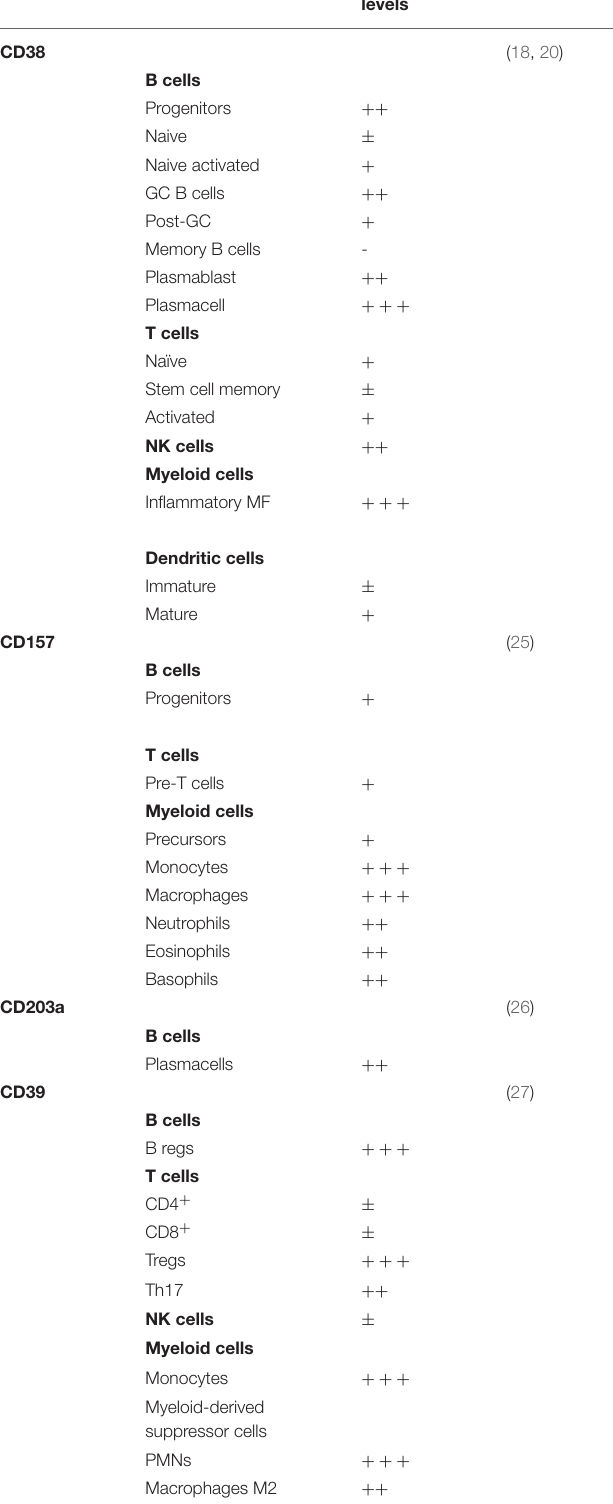
TABLE 1 | Pattern of ectonucleotidases expression in non-malignant blood cells.